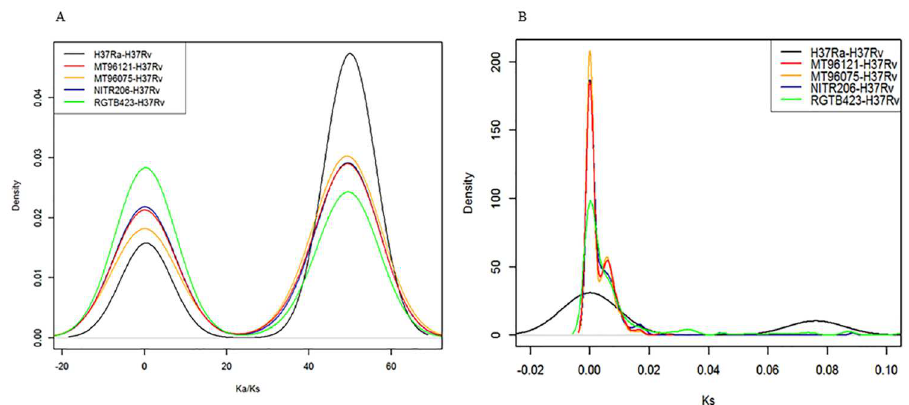
Fig 4. Distributions of Ka/Ks and Ks values for single-copy orthologs among M . tuberculosis strains. (A) The black, red, yellow, blue, and green lines represent Ka/Ks distributions of single-copy orthologousgene pairs in H37Ra-H37Rv, Manilafamily isolate 96121-H37Rv, Beijingfamily isolate 96075-H37Rv, NITR206-H37Rv and RGTB423-H37Rv, respectively.(B) The black, red, yellow, blue, and green lines representKs distributionsof single-copyorthologousgene pairs in H37Ra-H37Rv, Manilafamily isolate 96121-H37Rv, Beijingfamily isolate 96075-H37Rv, NITR206-H37Rv and RGTB423-H37Rv,respectively.